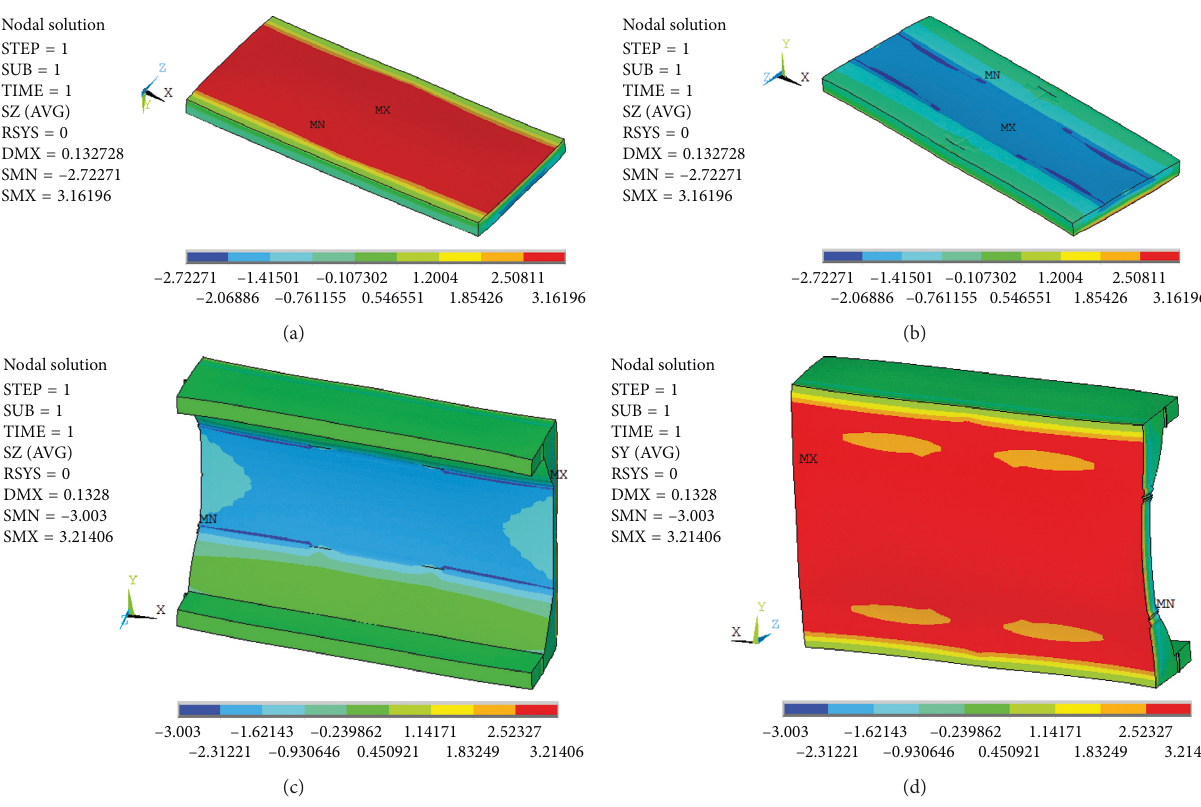
Figure 11: Stress distribution in bottom of the slab and web of the Arch rib when the temperature gradient drops 10 ° C. Normal stress distribution on (a) the inner surface of the bottom slab; (b) the outer surface of the bottom slab; (c) the inner surface of the web; (d) the outer surface of the